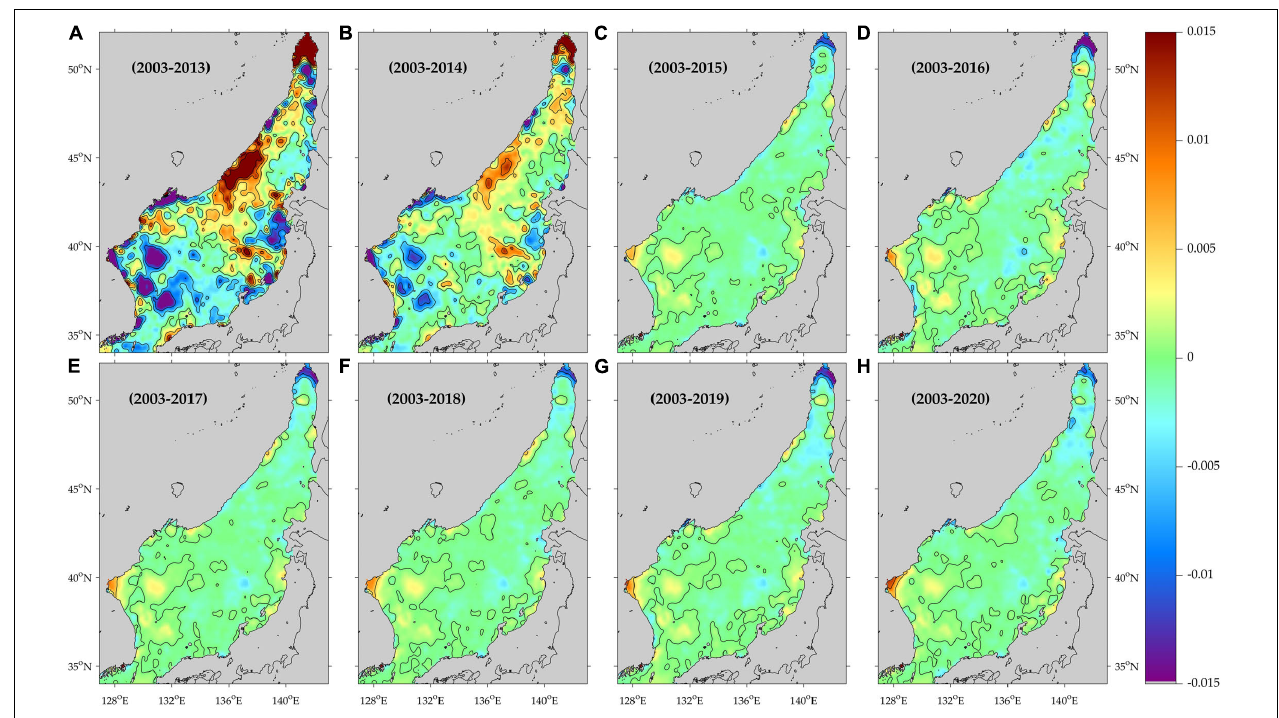
FIGURE 6 | Spatial distribution of the differences in MODIS chlorophyll- a concentration trends (mg m − 3 yr − 1 ) between ordinary trends and trends after removing seasonal to annual variations and (former minus latter) in the East Sea (Sea of Japan) for the periods of (A) 2003–2013, (B) 2003–2014, (C) 2003–2015, (D) 2003–2016, (E) 2003–2017, (F) 2003–2018, (G) 2003–2019, and (H)